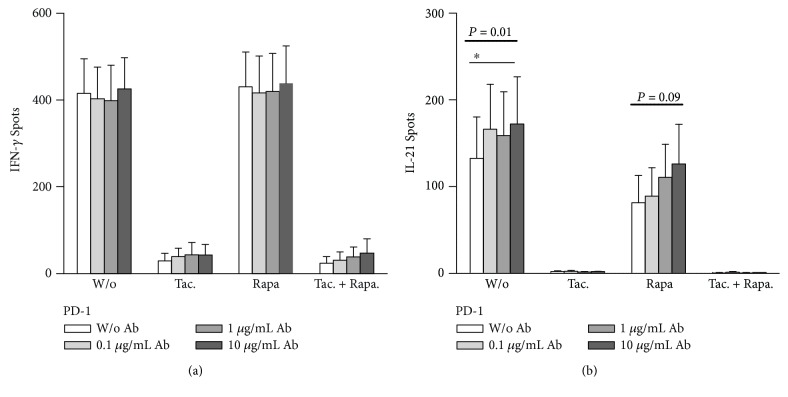
Increase of CMV-specific cytokine secretion by PD-L1 in healthy controls and effect of tacrolimus and rapamycin. The figure shows the production of IFN-γ (a) and IL-21 (c) without and with addition of PD-L1 antibodies in healthy CMV-positive controls. Lymphocytes were stimulated with CMV lysate. Stimulation with HEL-299 lysate served as negative control, resulting in average spot numbers of 2 per well (data included in the Supplementary file S3). The cells were grown without immunosuppressive drug or treated with tacrolimus (Tac.), rapamycin (Rapa.), or both drugs in combination (Tac.+Rapa.) and incubated with PD-L1 antibodies at concentrations of 0.1, 1, and 10 μg/ml. IFN-γ and IL-21 secretion was determined in six healthy controls. Mean and standard of the mean (SEM) of spot numbers are depicted. The effect of PD-L1 antibodies was analyzed by one-way ANOVA with a posthoc test. Values above the bold horizontal lines indicate P values obtained by the Friedman test, a significant result of Dunn's posthoc test (to compare the various concentrations) is given above the thin horizontal line (∗
P < 0.05).